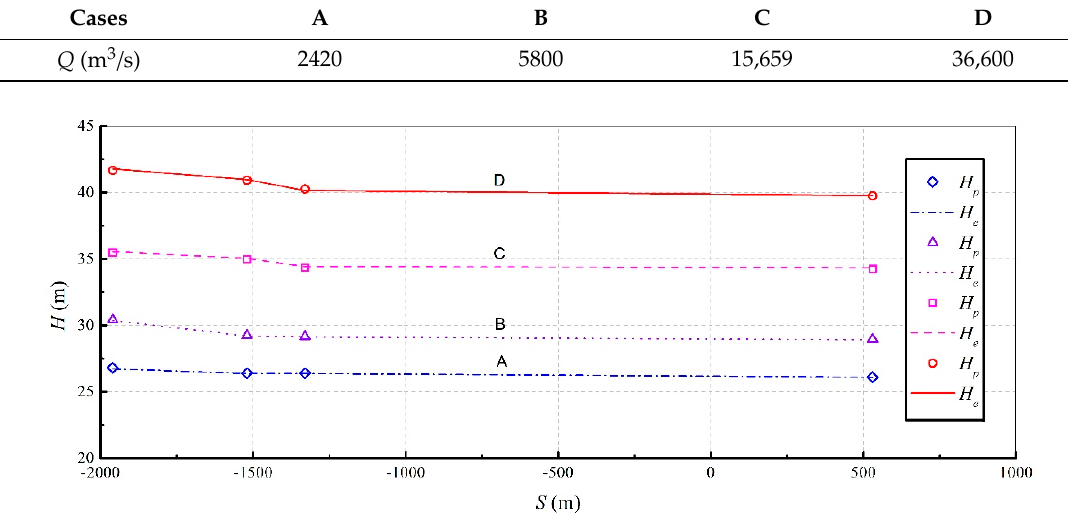
Figure 4. Comparison of the free surface between experiment and prototype.